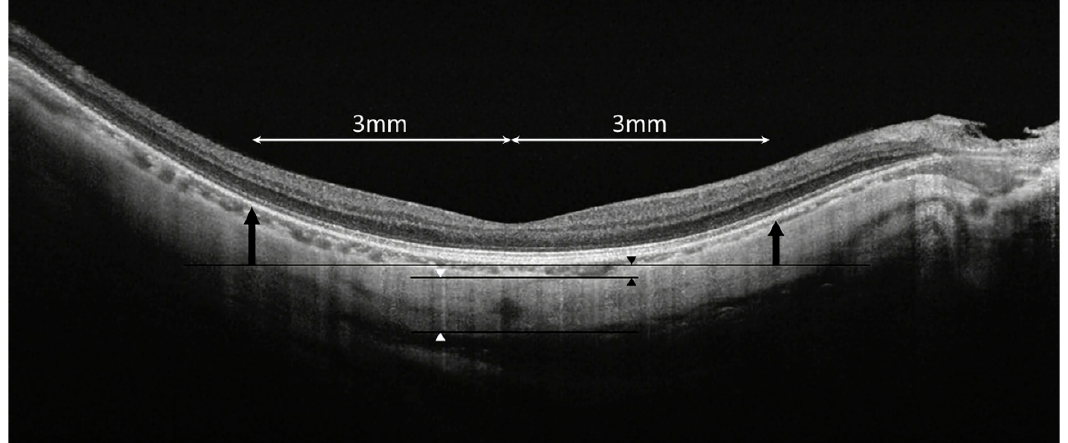
Figure 2. Diagram of SS-OCT image measurement. The macular outward scleral height (black arrows), central choroidal thickness (black arrowheads), and central scleral thickness (white arrowheads) were measured using DRI OCT Triton software built in SS-OCT.